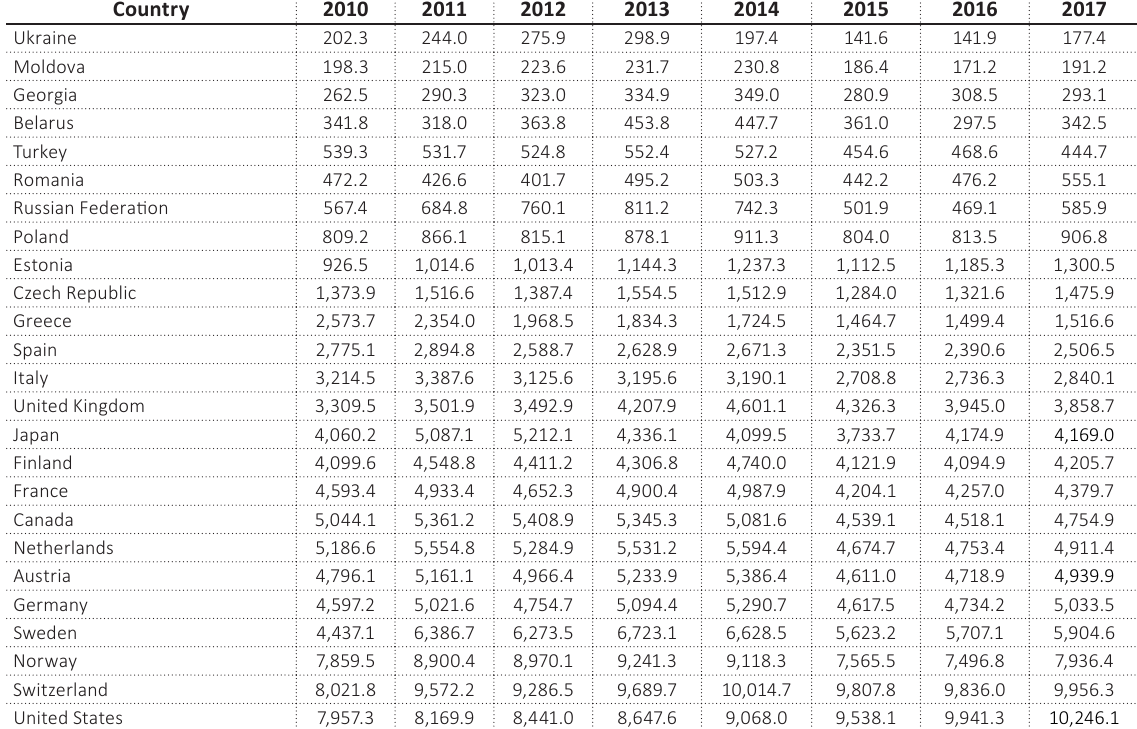
Table A2. Current health expenditure per capita (USD)